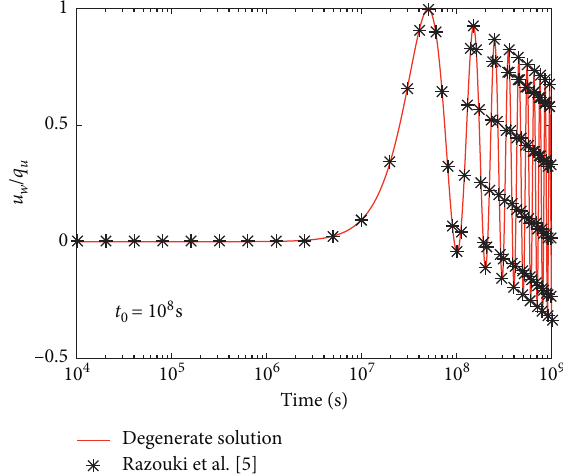
Figure 6: Comparison between the degenerate solution and the existing solution for haversine cyclic